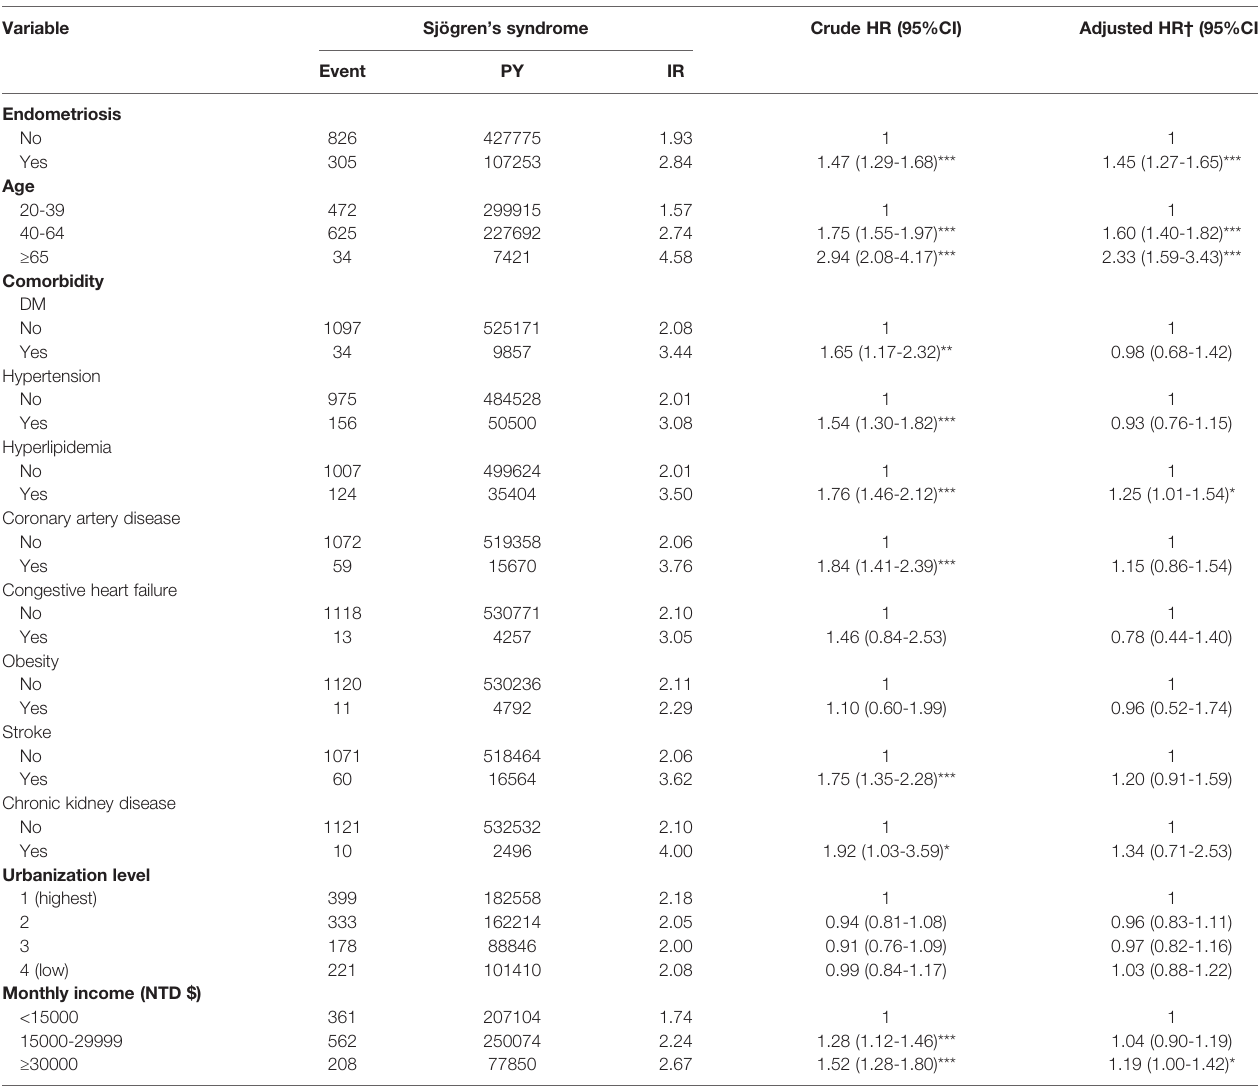
TABLE 2 | Cox regression analyses of Sjögren ’ s syndrome in patients with endometriosis.